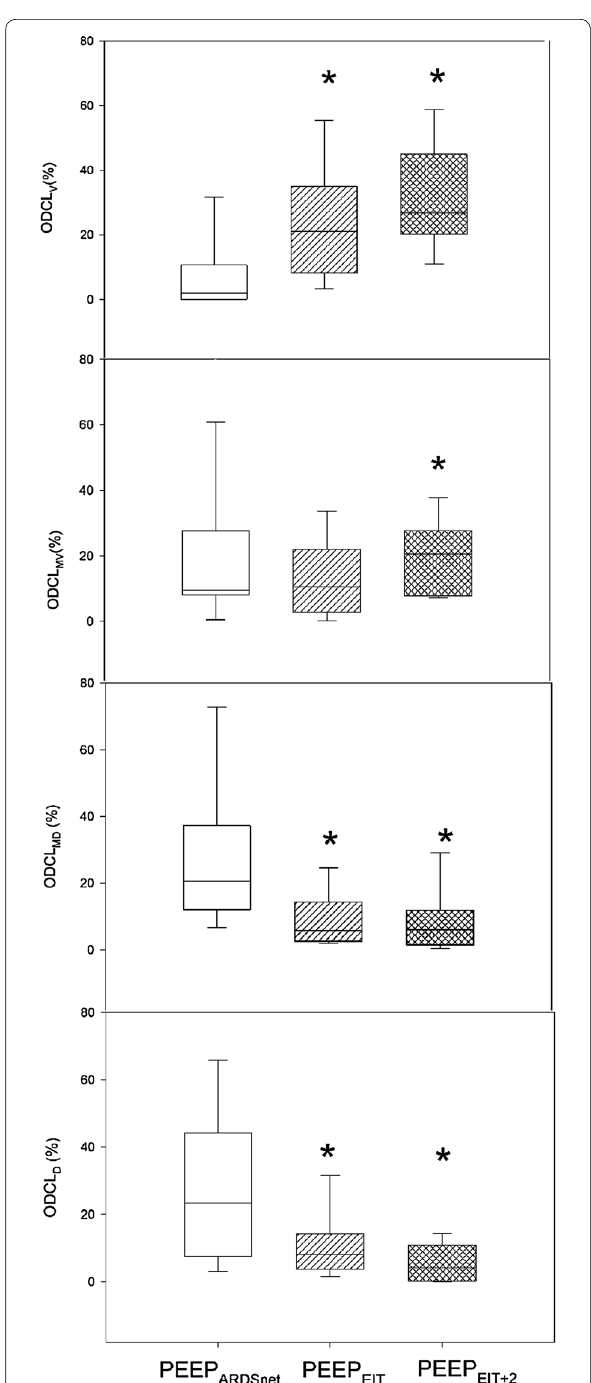
Fig. 4 Regional alveolar hyperdistension and collapse distribution in all study phases. Alveolar hyperdistension and collapse was signifi- cantly reduced in dependent lung layers and significantly increased in non-dependent lung layers compared with PEEP ARDSnet in both PEEP EIT and PEEP EIT phases. Furthermore, in middle-ventral lung + 2 layers alveolar hyperdistension and collapse was significantly higher in PEEP EIT phase compared with PEEP ARDSnet , but did not change in + 2 PEEP EIT step. * p < 0.05 compared with PEEP ARDSnet